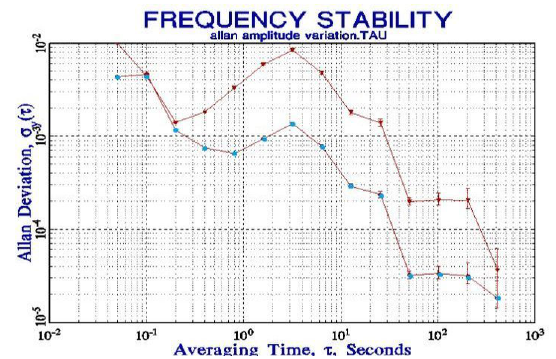
Figure 2 : Allan deviation curves for a non-compensated (blue dots) and compensated (red dots) signal, with a frequency of 100mHz and an amplitude of 500mV